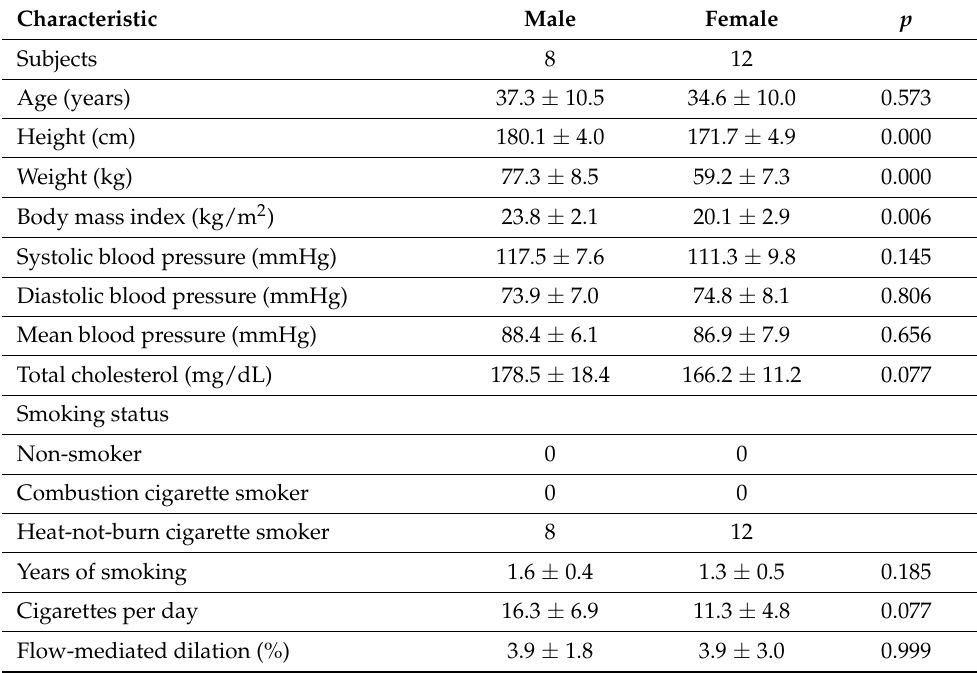
Table 4. Chronic users of heat-not-burn